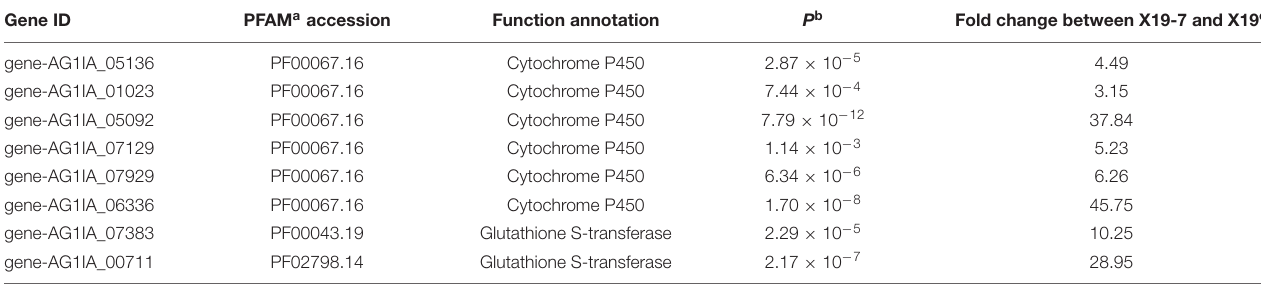
TABLE 2 | Transcriptome contigs encoding cytochrome P450 and glutathione S-transferase genes in wild-type strain X19 and SYP-14288-resistant mutant X19-7 of Rhizoctonia